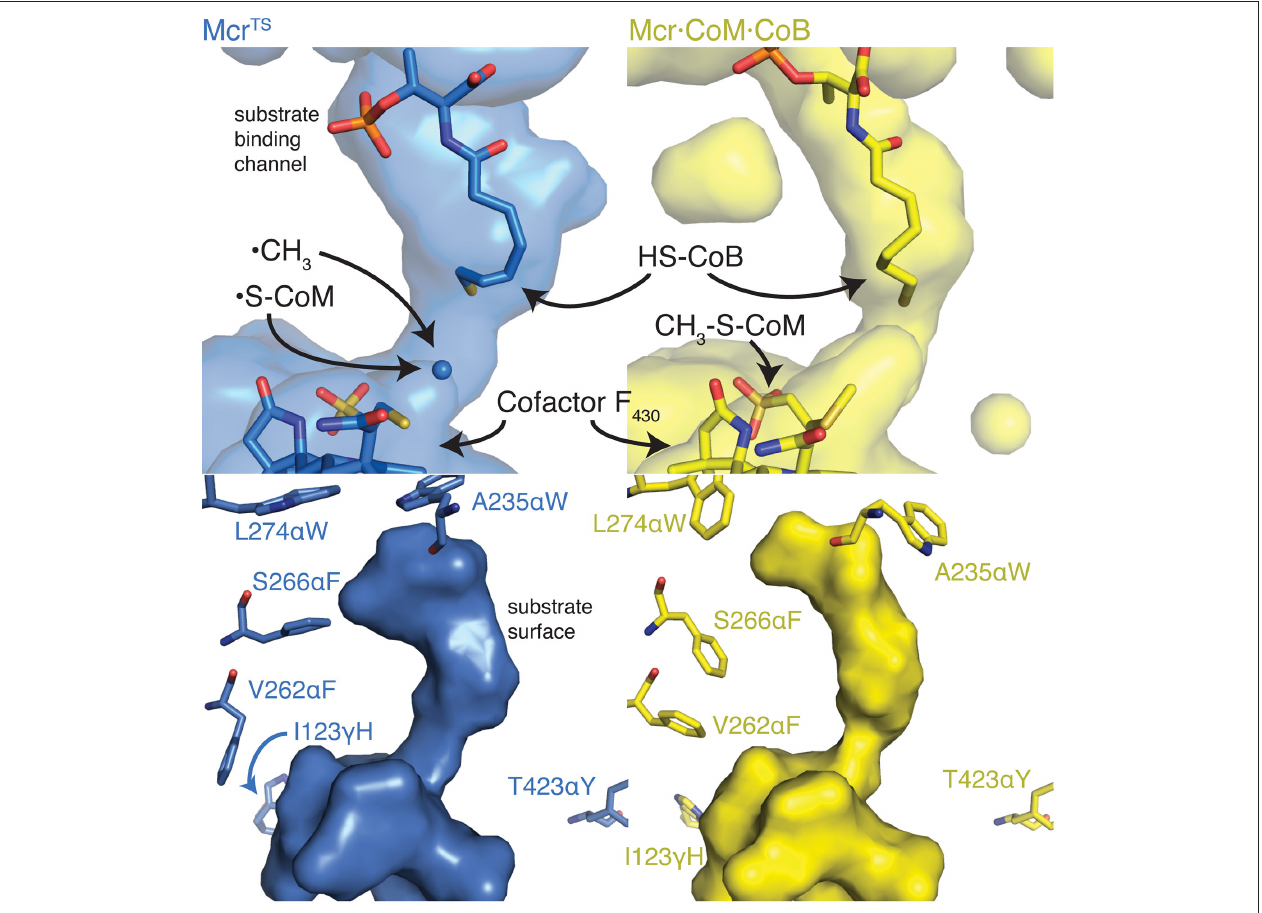
FIGURE 7 | The alternate conformations observed for the top CS3 variant’s design positions and their effect on the substrate binding channel. The top two panels show the cavities within Mcr nearby the active site. The long thin continuous surface is the substrate binding channel. The bottom two panels illustrate the substrate surface (i.e., not the cavity) and the design positions nearby the substrates. The enzyme structures depicted in blue (Left) and yellow (Right) represent the Mcr TS and Mcr · CoM · CoB structures, respectively. Key residues and molecules are shown as sticks, colored by atom type, and labeled. The conformation of the yellow side chains generally extend toward the substrate(s) and thus narrow the size of the substrate channel, forcing HS-CoB to assume a more compact